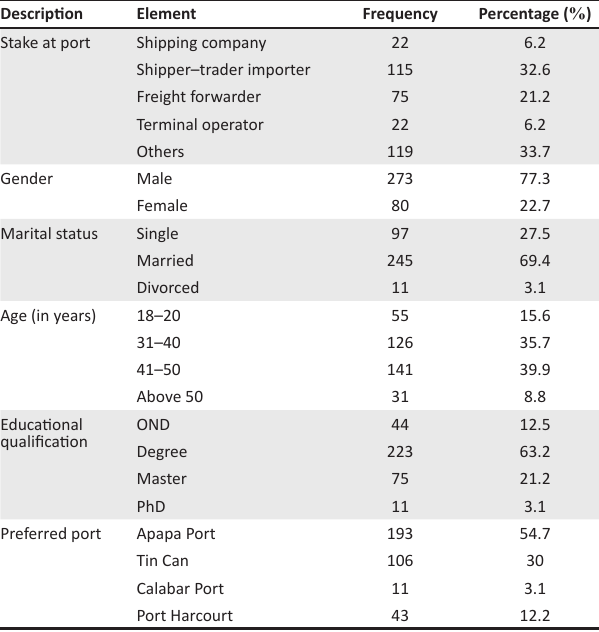
TABLE 1: Demographics of respondents.